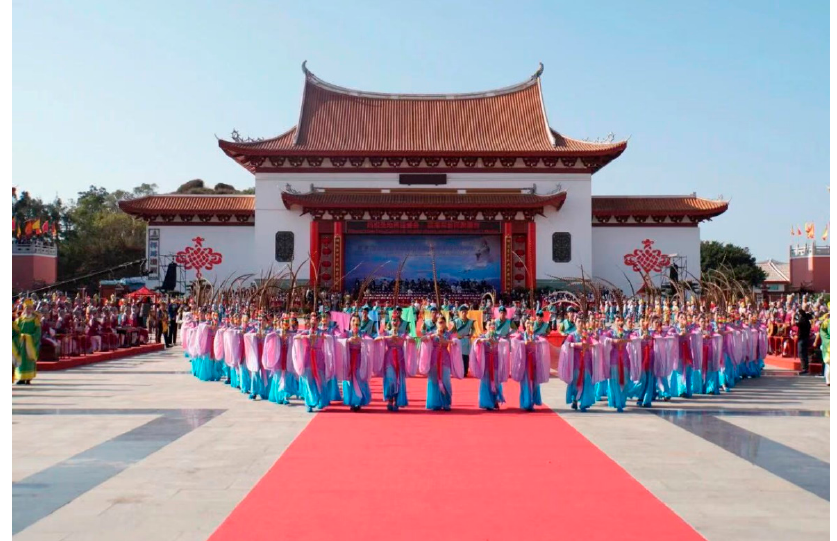
Figure 5. The performance of bayi. Source: the website of Meizhou ancestral temple https://weibo.com/mzmz323?refer_flag=1005055013_&is_all=1#_rnd1610641535373. Accessed on 10 July 2020. Reprinted with permission from the temple board of Meizhou ancestral temple.